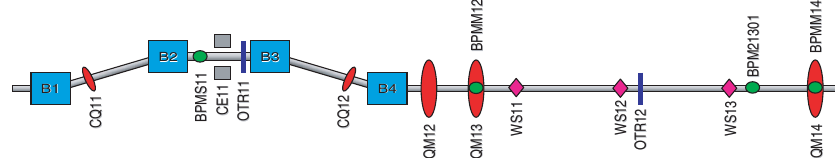
FIG. 2. (Color) Bunch compressor 1 (BC1) and its diagnostics section showing tweaker quads (CQ11 and CQ12) in the chicane for dispersion correction, BPMs, quadrupoles, OTR screens, and wire scanners (WS) for beam diagnostics.